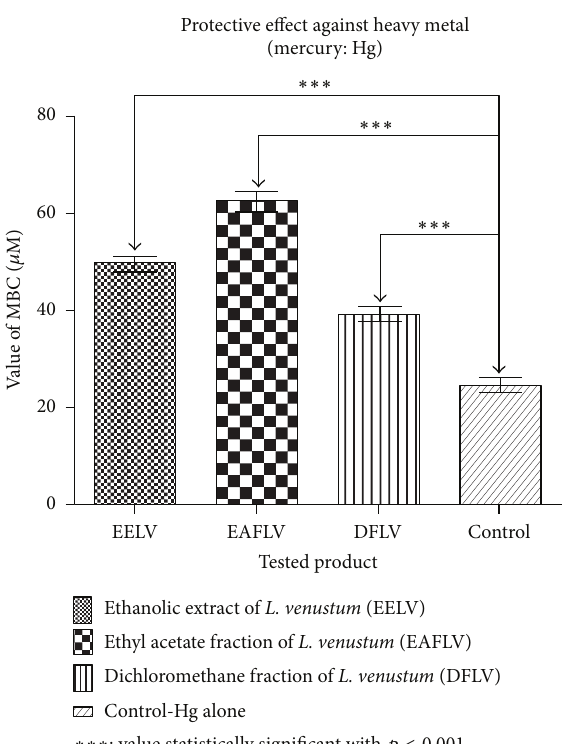
Figure 1: Chart showing the modulatory activity of the toxicity of mercury chloride towards E. coli 25922 in the presence and absence of ethanol extracts of Lygodium venustum and its fractions and a concentration of MIC/8 (128 𝜇